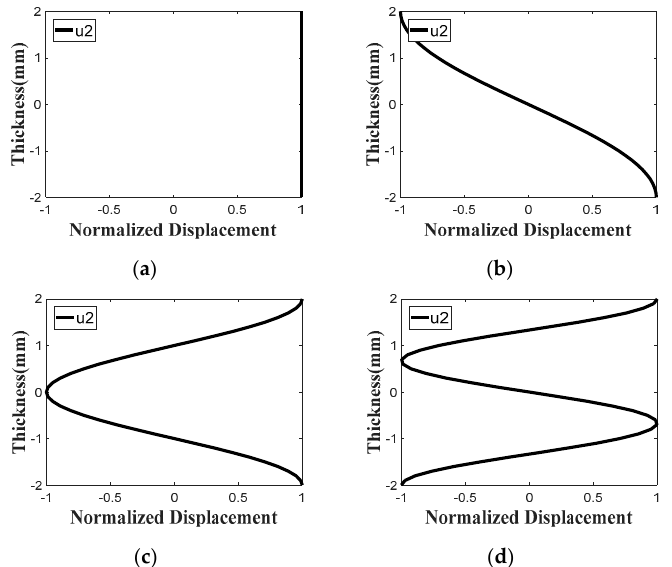
Figure 3. Wave structures of shear horizontal (SH) modes in the main vibration direction (cid:1873) (cid:2870) : ( a ) SH0;